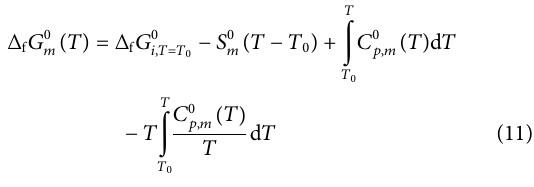
TABLE 2 Temperature parameters of the logarithmic Henry ’ s law constant (log K H,cp ) for the O 2 solubility in pure water, Eq. 8.